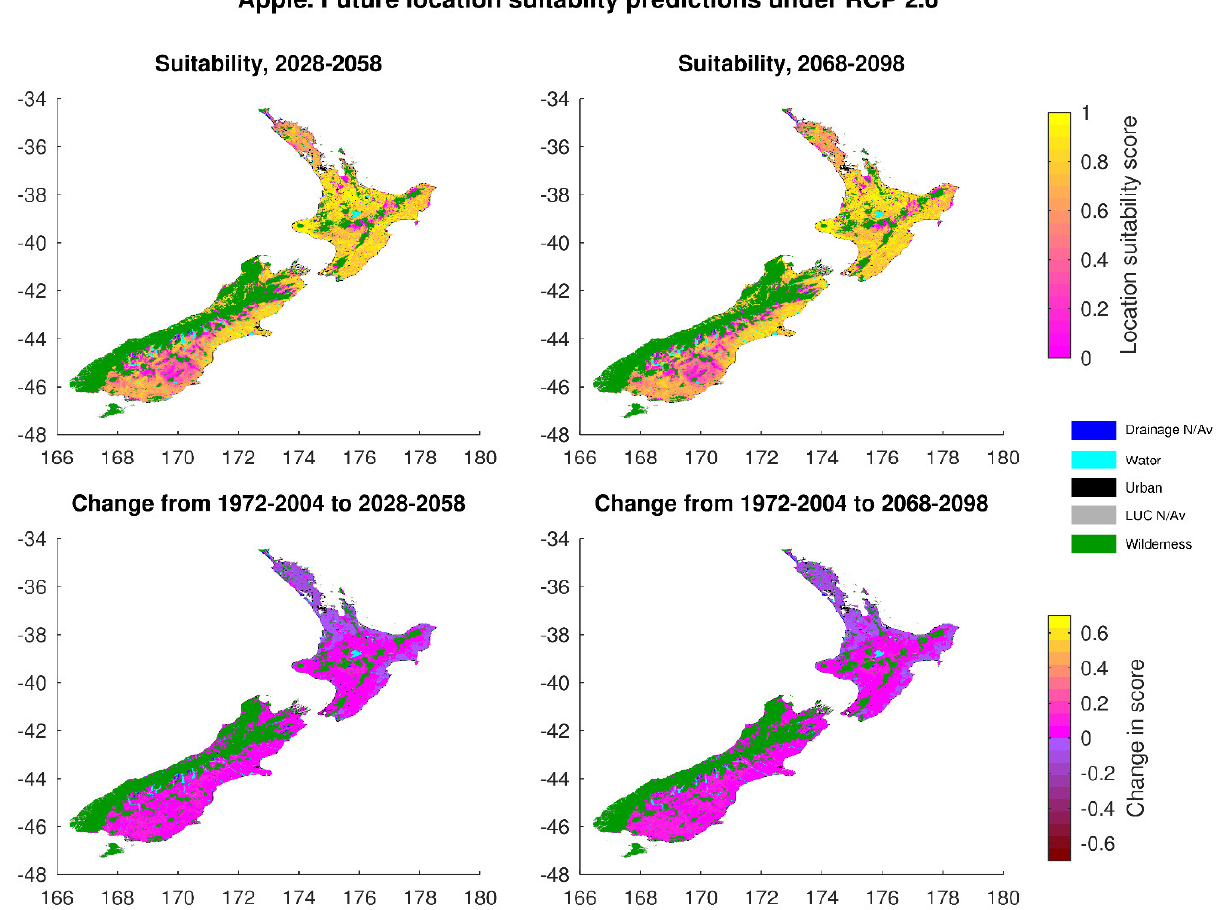
Figure 4. Apple: projected location suitability ( top panels) and projected changes in location suit- ability from the historic period ( bottom panels) for the mid-century ( left panels) and late-century ( right panels) in New Zealand under Representative Concentration Pathway (RCP) 2.6.